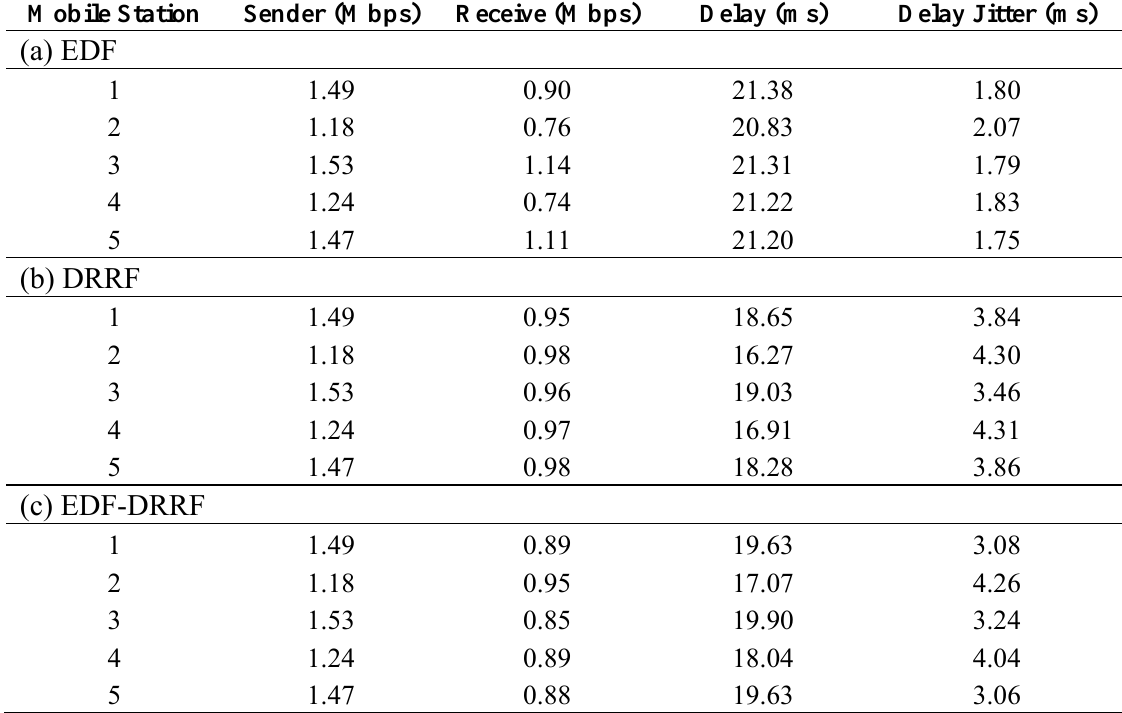
Table 7. System Throughput, Delay, and Delay Jitter with Deadline Enforced (5 Flows in Overload Scenario) (a) EDF, (b) DRRF, and (c) EDF-DRRF [13].